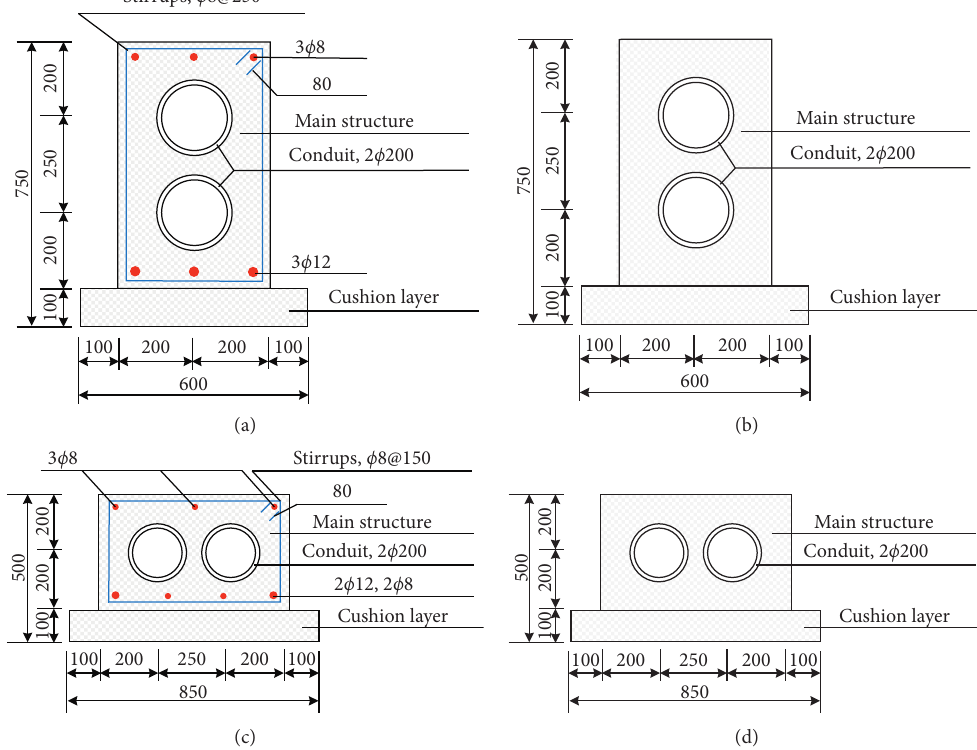
Figure 4: Test specimen arrangement (millimeters): (a) A1, (b) A2, (c) B1, and (d)